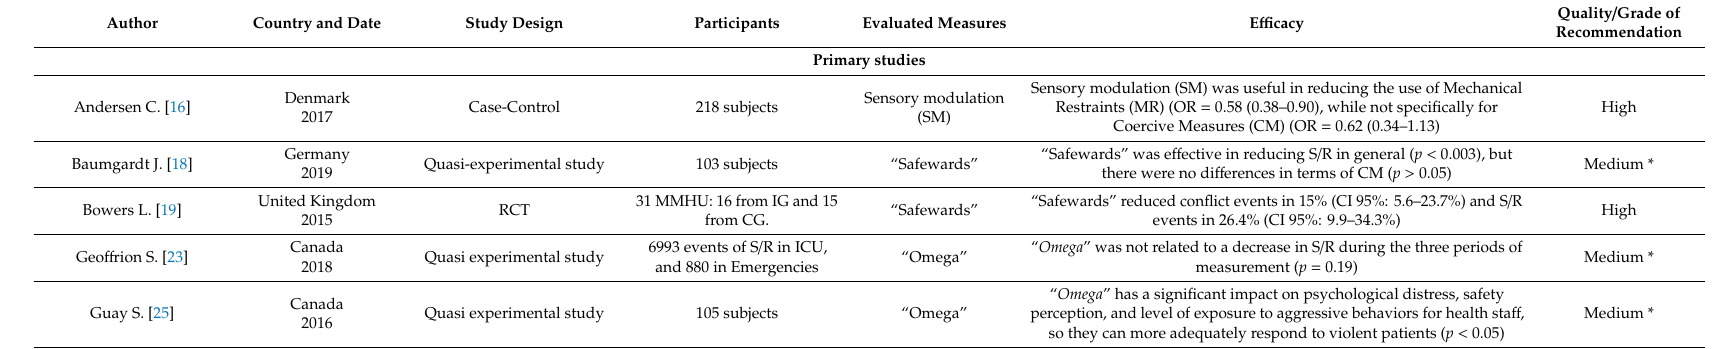
Table 4. Characteristics of the included